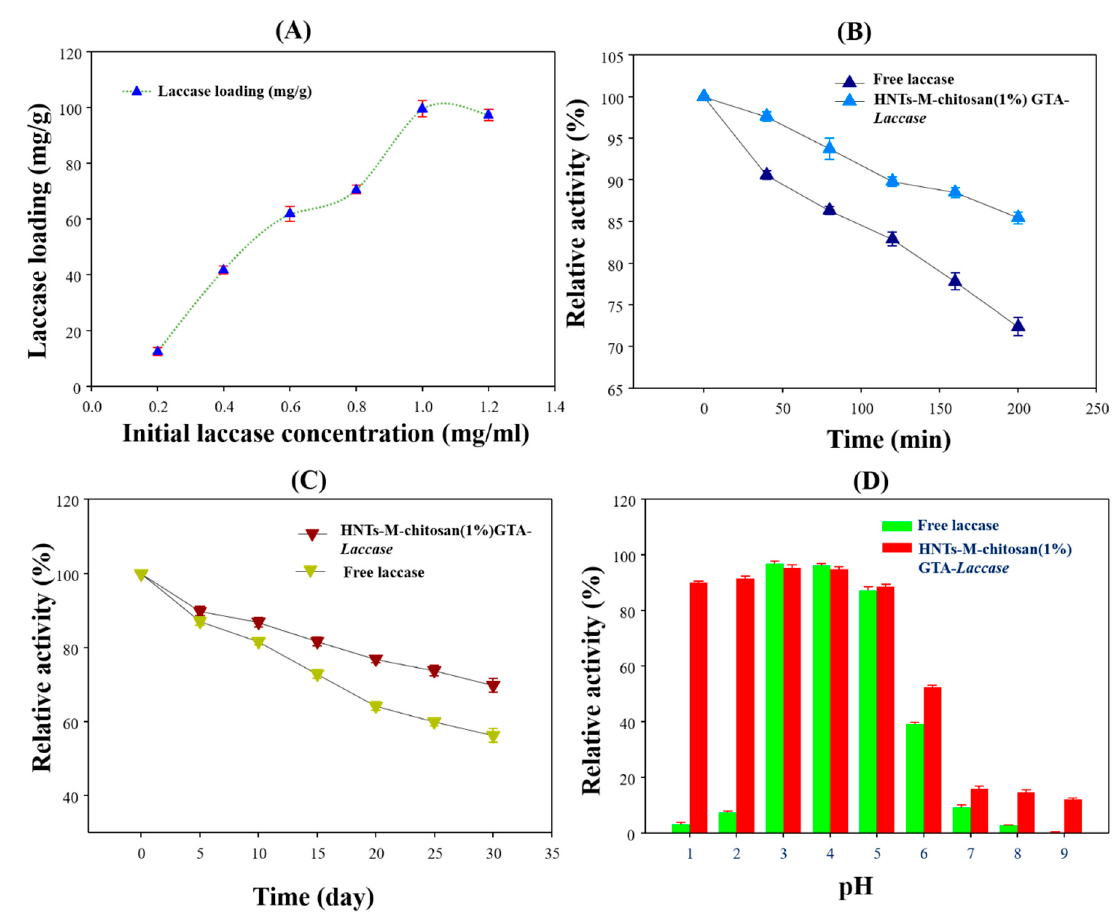
Figure 7. ( A ) Effect of initial laccase concentration on its loading on HNTs-M-chitosan (1%); ( B ) temperature stabilities of free and immobilized laccase; ( C ) time-duration stabilities of free and immobilized laccase; and ( D ) pH stabilities of free and immobilized